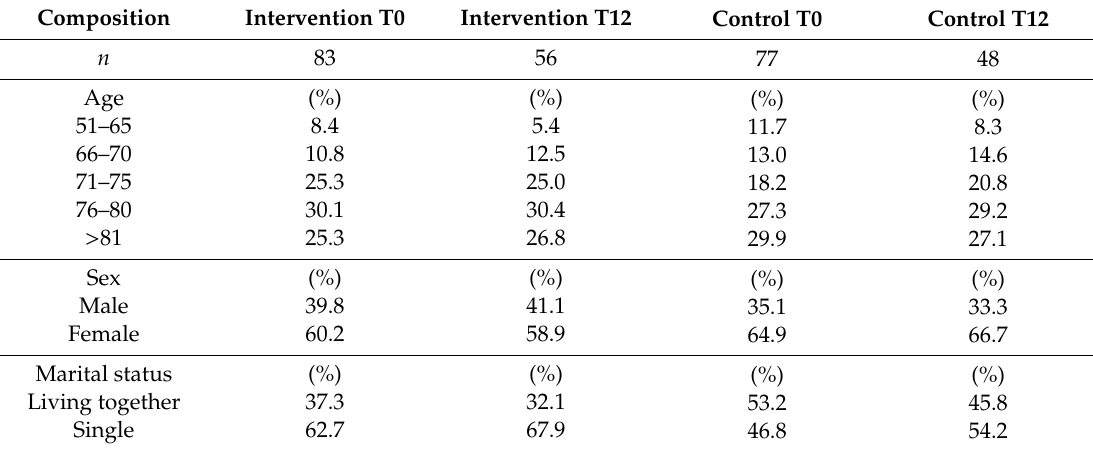
Table 1. Composition of intervention and control group at di ff erent